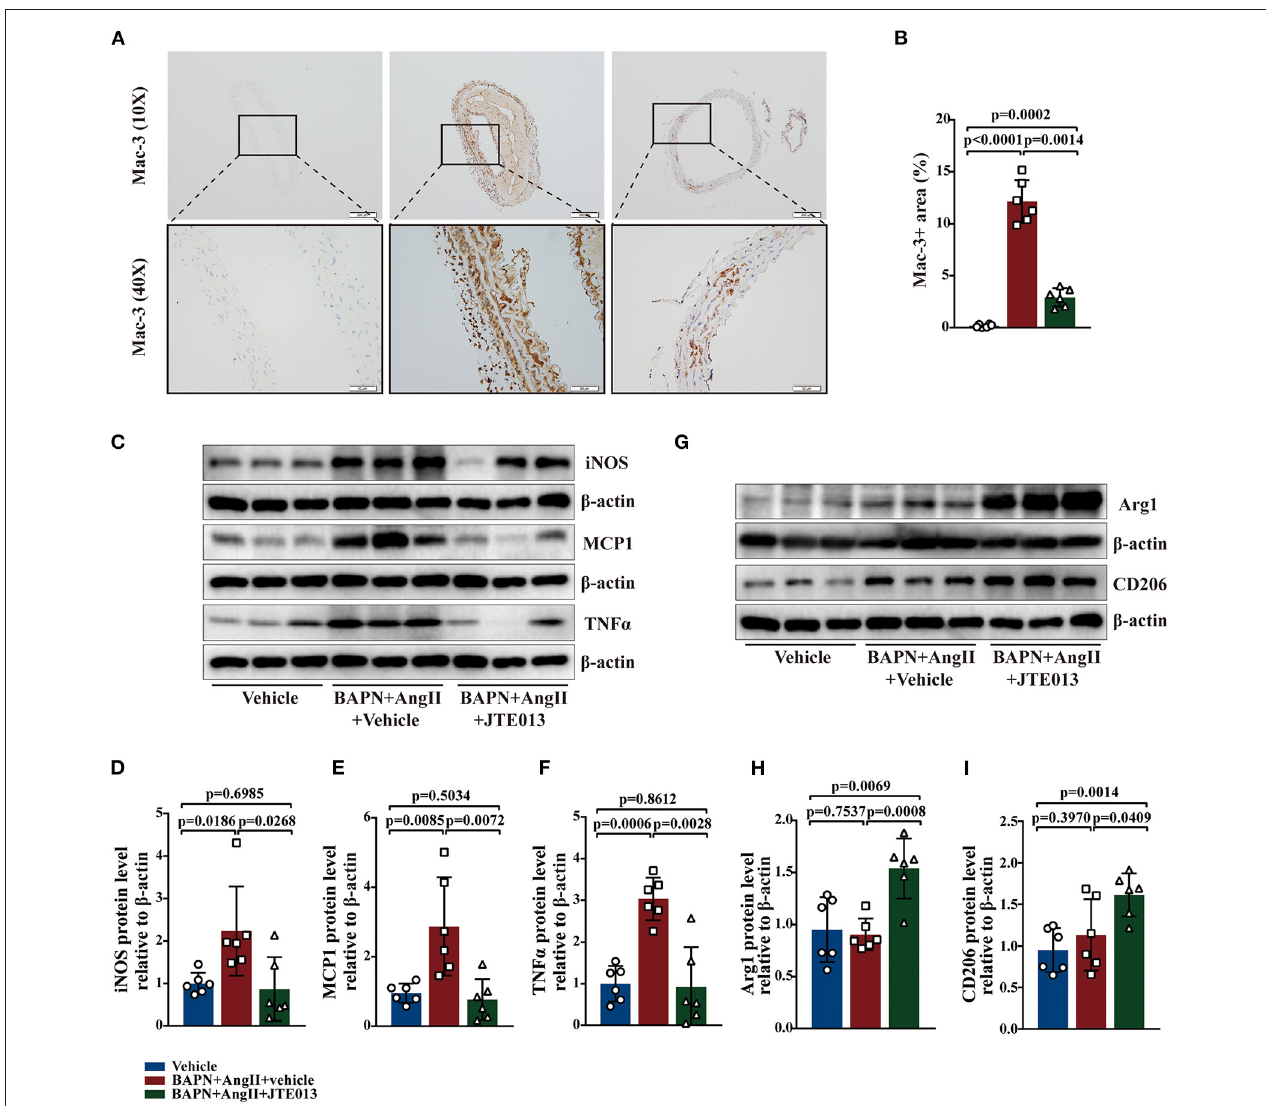
FIGURE 5 | Inhibition of S1PR2 by JTE013 diminished macrophages accumulation and the hallmarks of M1 macrophage. (A,B) Lesion Mac-3 + area and corresponding analysis ( n = 6). (C–F) Representative immunoblot and the corresponding analysis of mouse iNOS, MCP1, and TNF α in each group ( n = 6). (G–I) Representative immunoblot and the corresponding analysis of mouse Arg1 and CD206 ( n = 6). Scale: 200 µ m, inset: 50 µ m. Data are expressed as means ± SD. of neutrophil apoptosis to NETs formation in vitro (25).